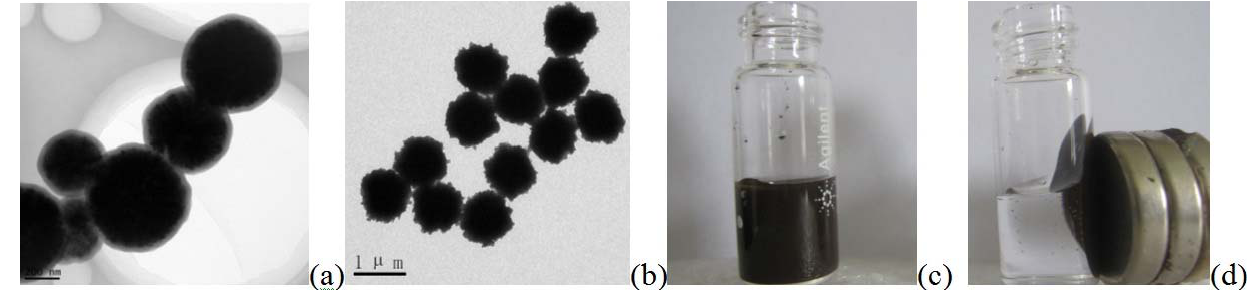
Figure 2. Transmission electron microscopy (TEM) images of ( a ) Fe and ( b ) MNPs-p24 Ab1 and ( c ) MNPs-p24 Ab1 capture probes in the absence and ( d ) presence of an external magnetic field ( d ,